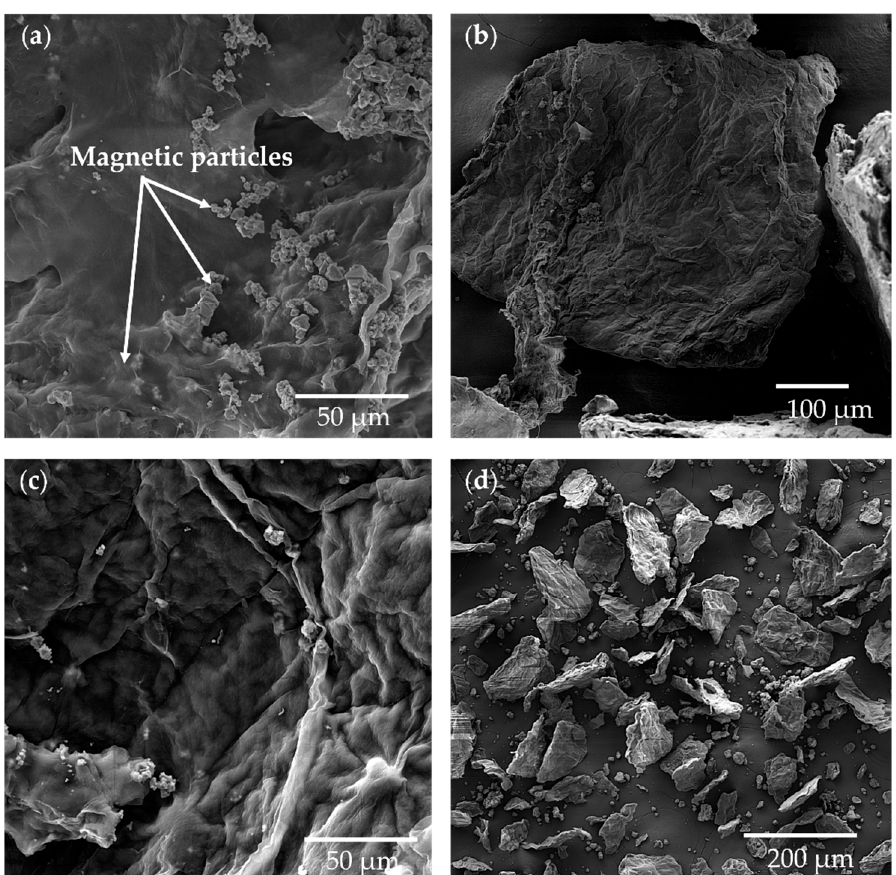
Figure 5. The SEM images of BC modified by 2.5% CA with NiFe 2 O 4 particles ( a,b ) and MgFe 2 O 4 ( c,d ) magnetic particles. The pictures were done with 1000- and 100-times magnification.